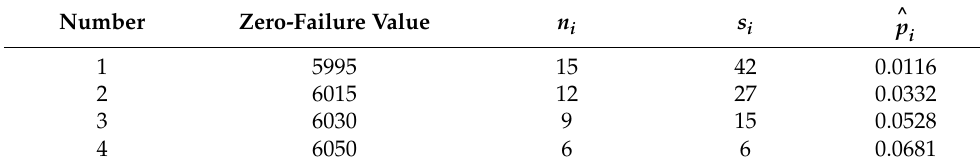
Table 2. Zero-failure data.